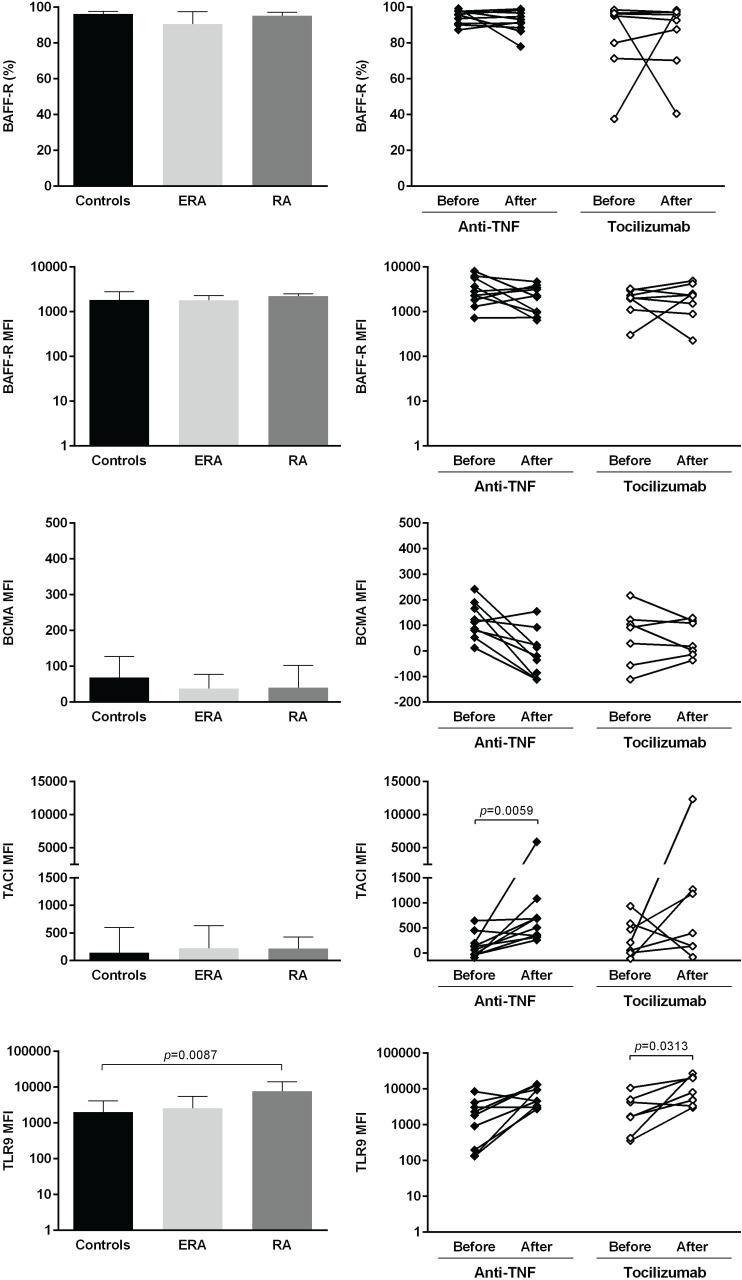
TACI, but not BAFF-R or BCMA, and TLR9 B-cell expression increase after treatment with TNF-inhibitors and tocilizumab in rheumatoid arthritis.The expression of B-cell activating factor receptors (BAFF-R, BCMA, TACI) and toll-like receptor 9 (TLR9) was analyzed on B-cells (frequency and median fluorescence intensity, MFI) to characterize B-cell phenotype in circulation in early RA (ERA) and established RA patients under methotrexate treatment. The effect of TNF-inhibitors and tocilizumab treatment on B-cell markers expression was also assessed in established RA patients at baseline and after an average of 8 months of treatment. Bars represent median values with interquartile range. Differences were considered statistically significant for p<0.05. Non-parametric Mann-Whitney test was used for comparisons between 2 independent groups. For paired samples (before and after treatment), the Wilcoxon signed-rank test was used.